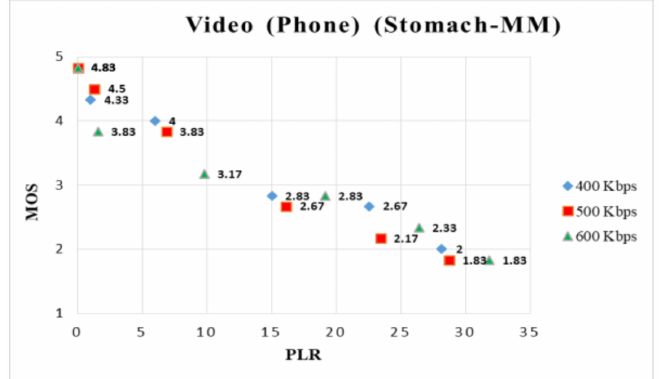
Figure 10. MOS ratings for stomach ultrasound (MM) on